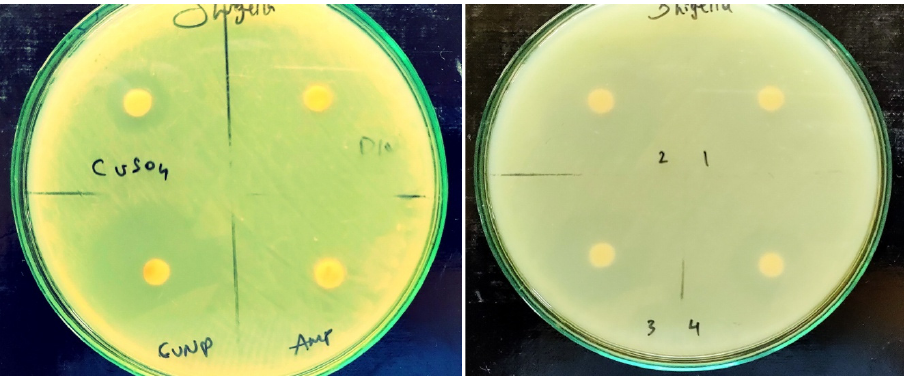
Fig. 11A. & Fig. 11B. Antimicrobial sensitivity of Shigella sp.